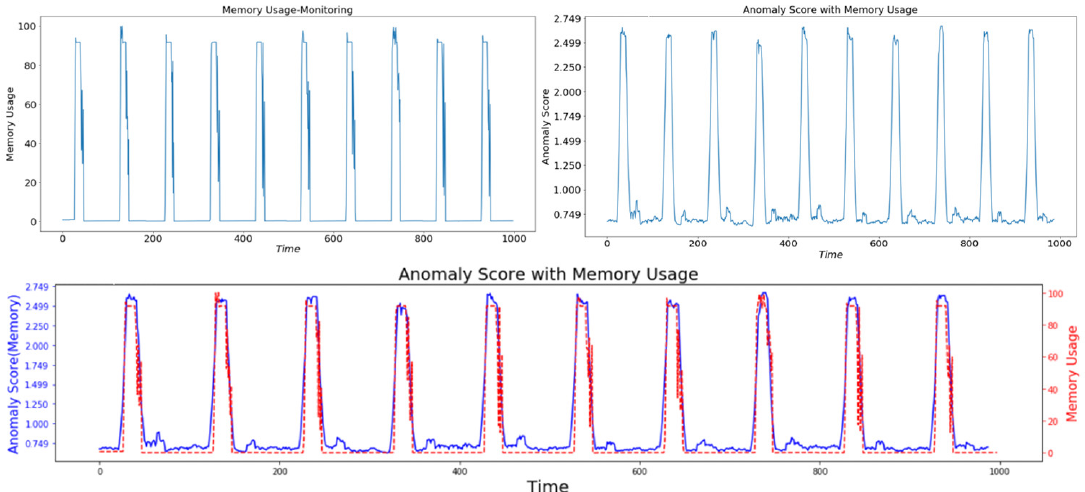
Figure 6. Anomaly Score (Memory Fault).